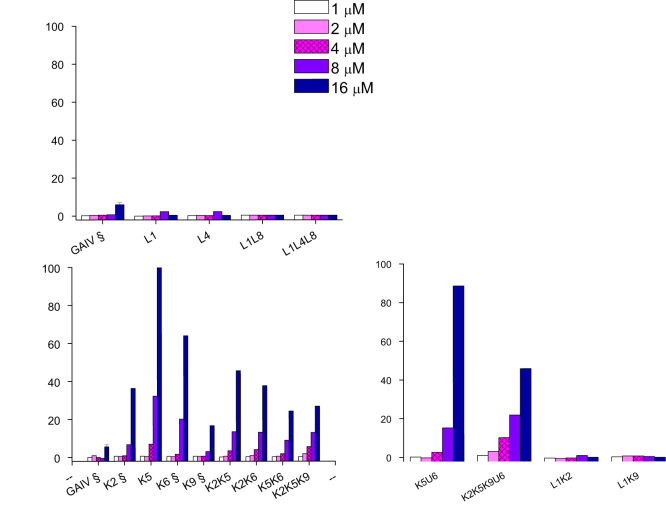
Hemolytic activity of trichogin and its analogs. Erythrocytes were treated for 24 h with different concentration of peptides, centrifuged and hemoglobin release was measured spectrophotometrically. Hemolysis is expressed as percentage relative to positive control (erythrocytes treated with distilled water). § Indicates data from [6] for comparison.